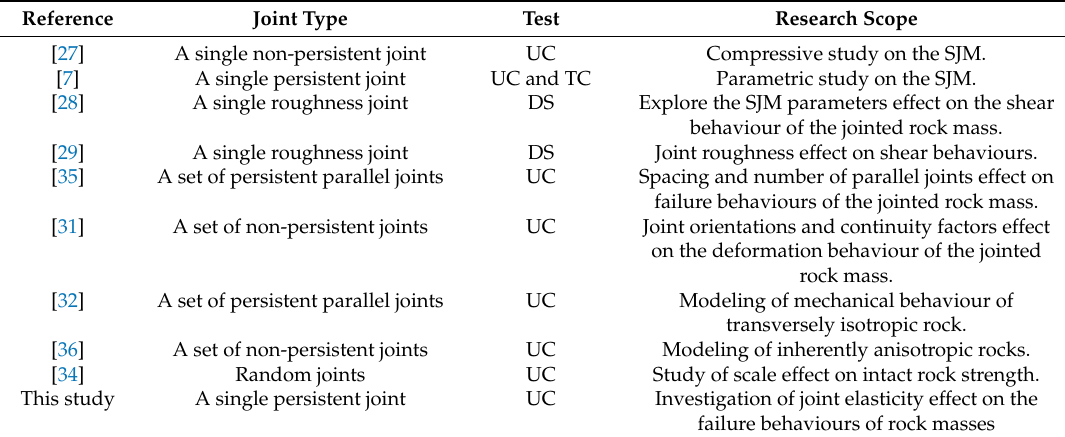
Table 1. Summary of previous studies using the